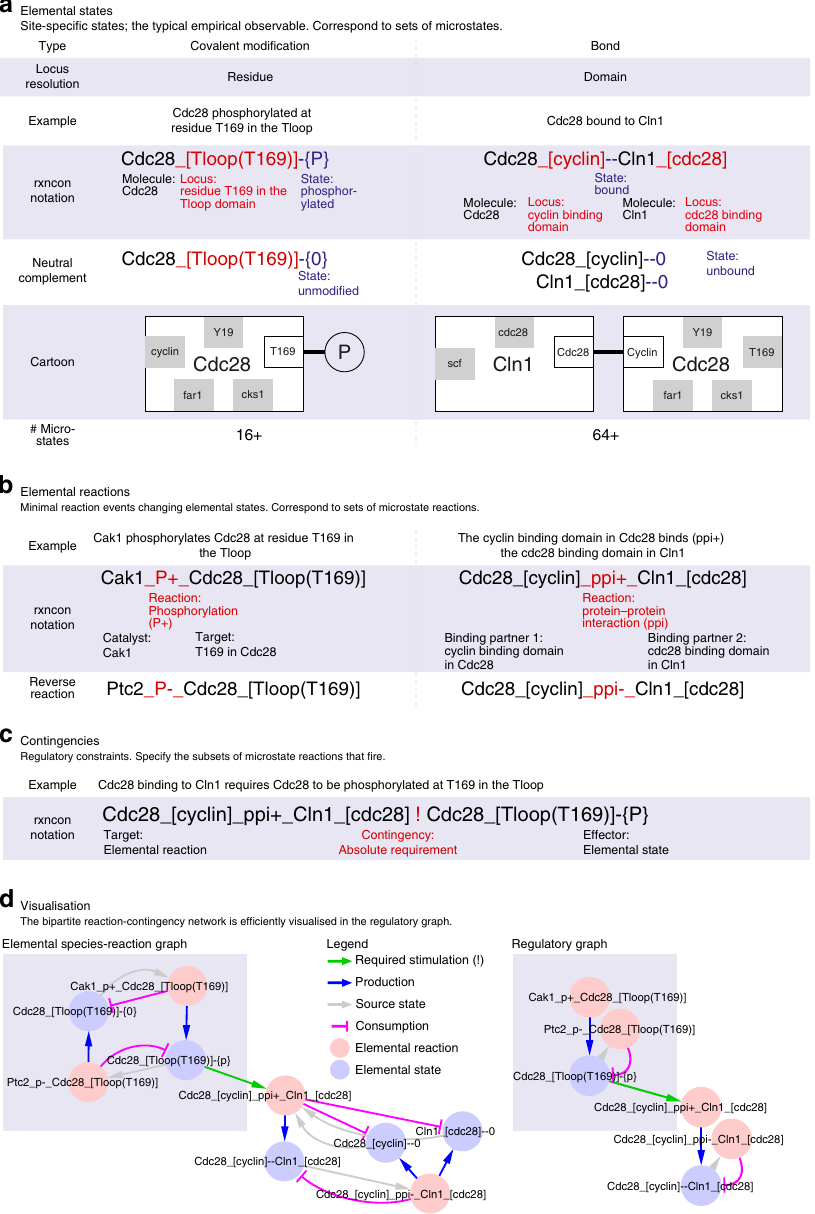
Fig. 1 The reaction-contingency (rxncon) language employs three essential components: elemental states, elemental reactions and contingencies. The regulatory graph ef fi ciently represents the regulatory structure of the network. a Elemental states are empirical observables: signalling molecules encode information through site-speci fi c state changes, i.e. covalent modi fi cation of speci fi c residues or bonds between speci fi c domains. All elemental states at a single locus are mutually exclusive with each other and their neutral complements (unmodi fi ed and unbound, respectively). However, each elemental state only de fi nes the state at a single locus (two for bonds; cartoon: white boxes), leading to a one-to-many relationship between the (empirically measured) elemental states and the (inferred) microstates. b Elemental reactions are indivisible reaction events de fi ned in terms of elemental states. They are only de fi ned in terms of the elemental states that are produced, consumed, synthesised or degraded, similar to the reaction centre of a rule in RBMs, and hence have a one-to-many relationship to microstate reactions. c The contingencies de fi ne constraints on an elemental reaction in terms of elemental states (or inputs) that do not change through the reaction. Hence, the contingencies reduce the number of valid microstate reactions, and correspond to the reaction contexts of RBMs. Boolean contingencies, employing AND, OR and NOT gates, can specify arbitrarily detailed constraints down to microstates as necessary. Due to this adaptive resolution, rxncon models can faithfully mirror the empirical knowledge. d The regulatory graph (right) provides a compact representation of the regulatory structure of the rxncon network. It is a simpli fi ed version of the elemental species-reaction graph (left), leaving out the neutral states to reduce graph complexity, to remove non-informative cycles, and to improve readability. Both graphs are bipartite, with two types of nodes and two types of edges: reaction-to-state (reaction) edges show the effect of each reaction on its source and product states, and state-to-reaction (contingency and source state) edges the impact of states on reactions. The bipartite nature of the graph highlights the requirement for both reactions and contingencies for information transfer through the network, as both types of edges are necessary to traverse the